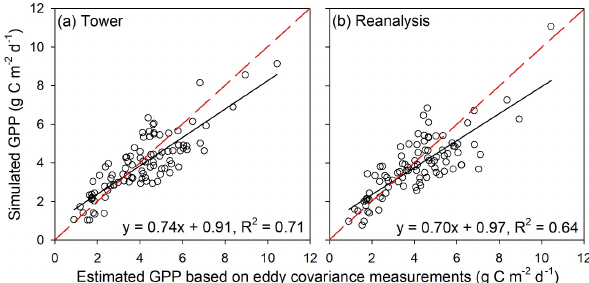
Figure 1. Comparisons between annual mean GPP estimated from EC towers and annual mean GPP simulated by the revised EC-LUE model. The modeled GPP values were simulated using (a) tower- derived meteorology and (b) global reanalysis meteorology. The black lines are the regression lines, and the red dashed lines are the 1:1 lines. The equations at the bottom of each panel are the regression equations derived from all the